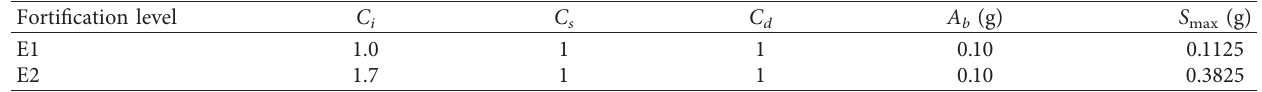
Figure 9: Fragility curves of key sections under the transverse seismic action. (a) Slightly damaged. (b) Moderately damaged. (c) Severely damaged. (d) Completely damaged. Table 6: The relative parameters and results of S max at the bridge location.